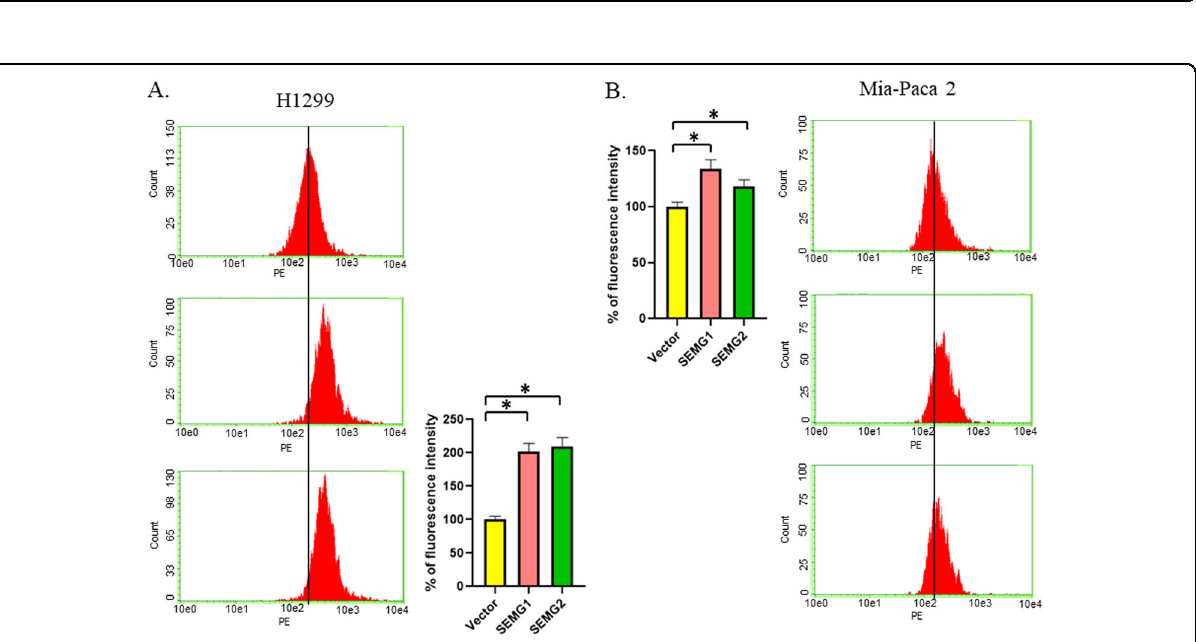
Fig. 7 SEMG1 and SEMG2 enhance ROS production. The fl ow cytometry of DHE (which predominantly detects superoxide) fl uorescence in A H1299 or B Mia-Paca 2 cells overexpressing SEMG1, SEMG2 or control vehicle. Fluorescence Data of three experiments were used and are presented as mean ± S.D., * P <